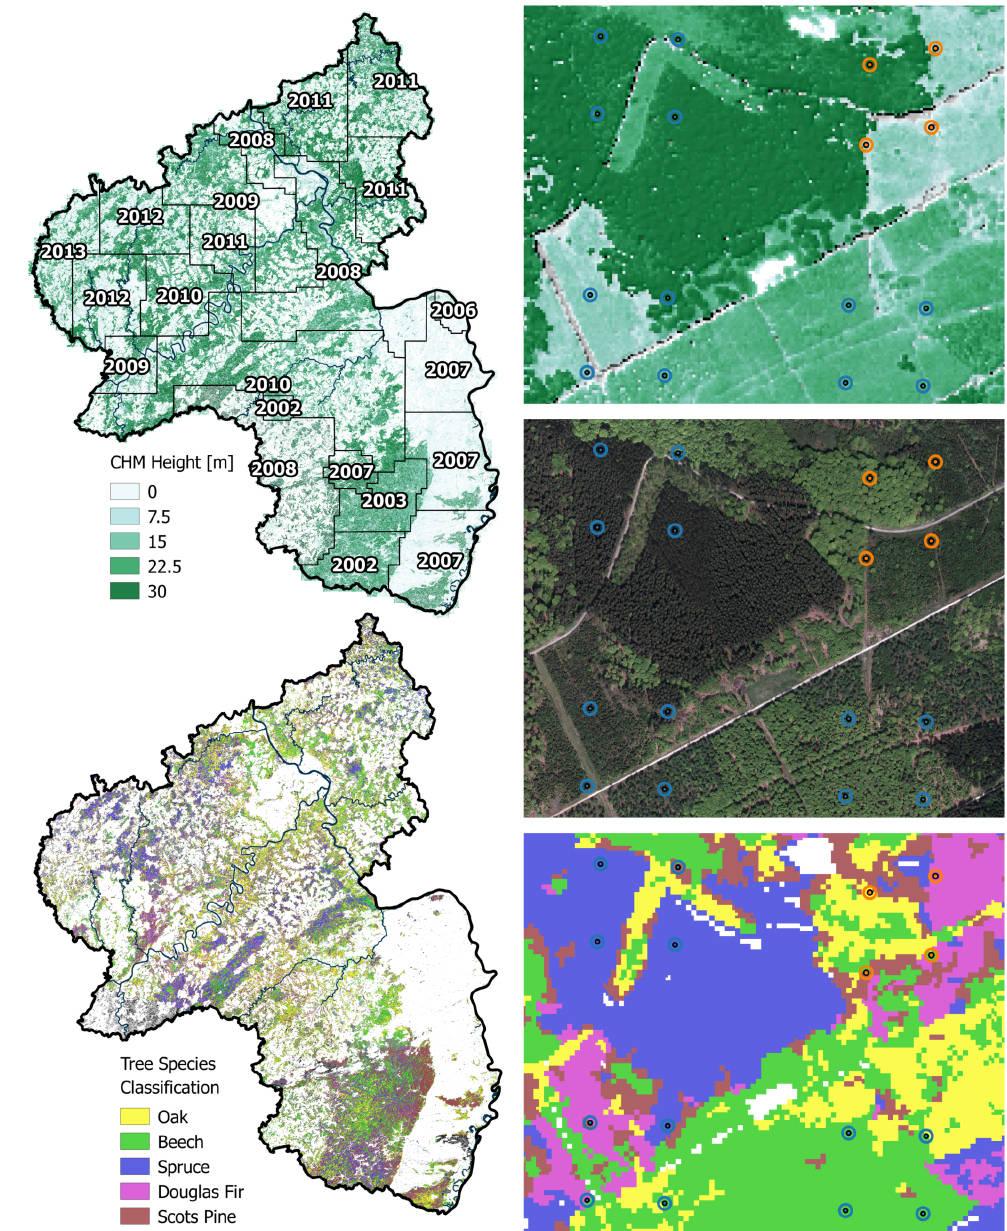
Figure 2. ( Left ): CHM (top) and tree species classification map (bottom) available on the federal state level. ( Right ): Magnified illustration of the supports used to derive the explanatory variables from the auxiliary data. From top to bottom: CHM, aerial image, tree species